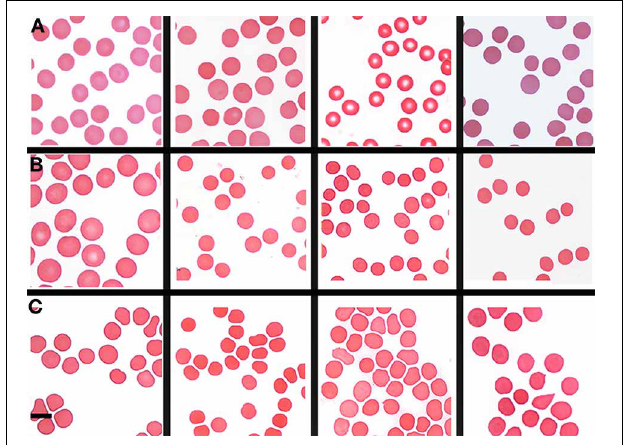
FIGURE 4 | Light microscopy smears of (A) four healthy individuals and (B) four normal and (C) four high normal serum ferritin (SF) Alzheimer’s (AD) individuals. Scale = 5 µ